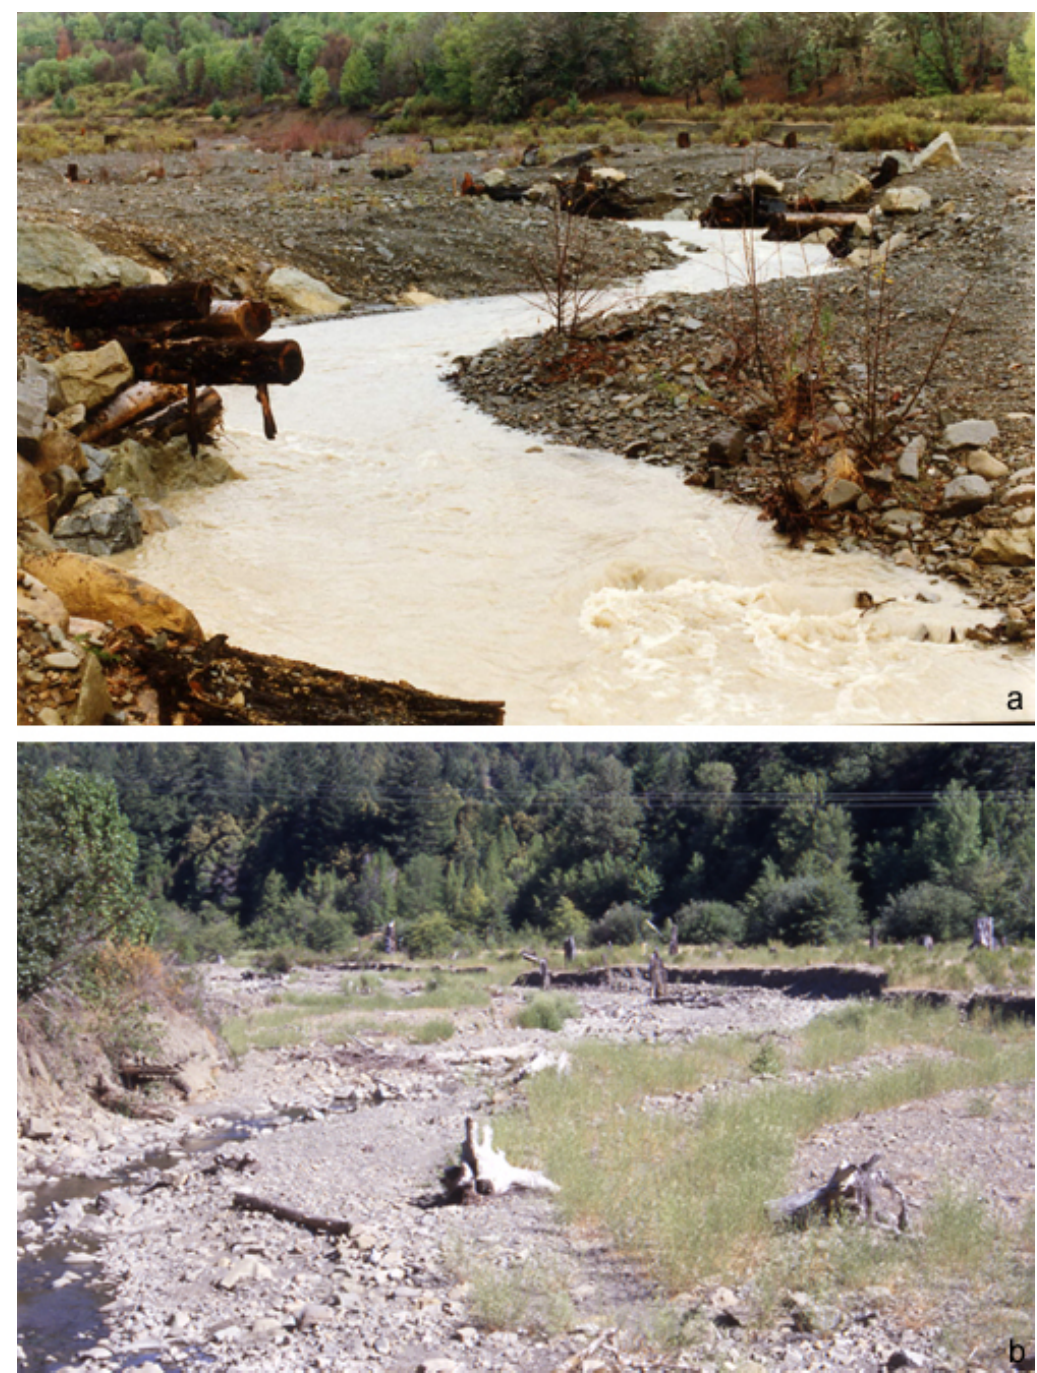
Fig. 4 . Channel of Cuneo Creek (a) after reconstruction in 1991 (photograph courtesy of the California Department of Parks and Recreation) and (b) in 2000 (photograph by the author, July